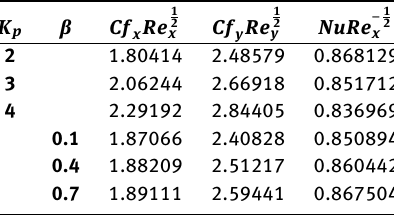
Table 1: Values of skin friction coefficient and Nusselt number for K p and β .